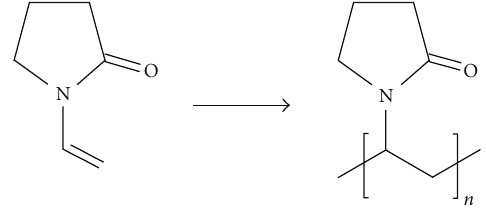
Figure 1: Polymerization of N -vinylpyrrolidone.